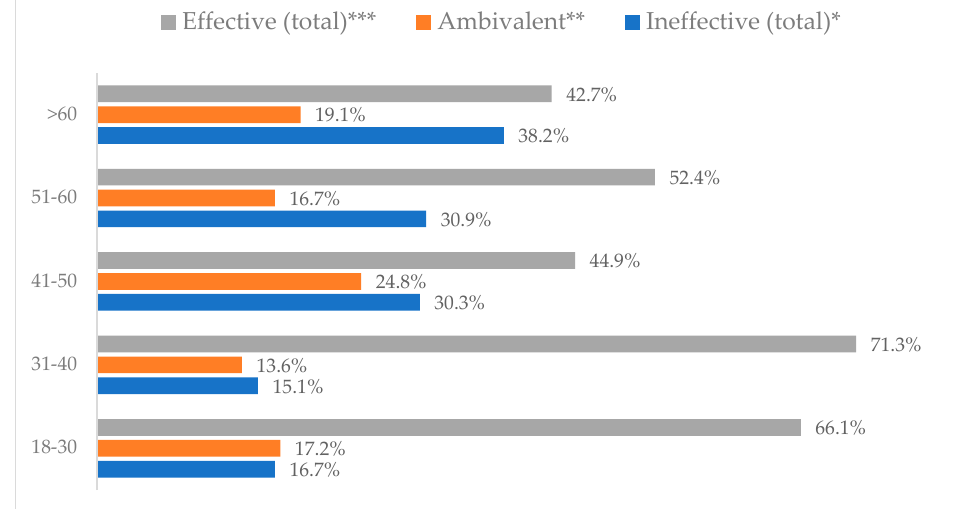
Figure 12. Influenza vaccination to prevent influenza virus infection by age ( N = 905). * Sum of responses: completely ineffective, ineffective, rather ineffective; ** Response: neither ineffective nor effective; *** Sum of responses: rather effective, effective, completely effective.